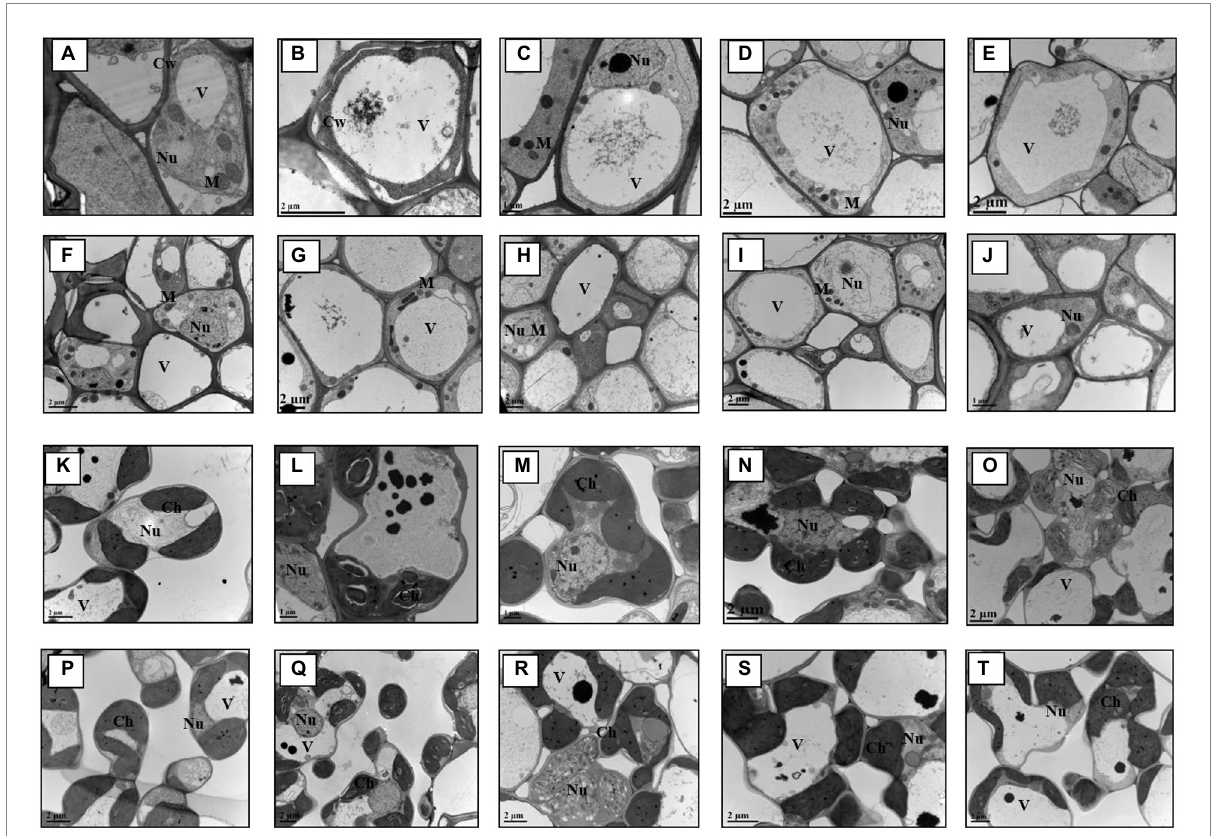
FIGURE 3 Transmission electron micrographs of root and leaf cells. Key: (A–J) = Root; GD-6: A = Control; B = As; C= Serendipita indica + As; D = S. indica + As + Phosphorus; E = As + Phosphorus; ZZY-1: F=Control; G = As; H= S. indica + As; I = D= S. indica + As + Phosphorus; J = As + Phosphorus. (K–T) = Leaves; GD-6: K=Control; L = As; M = S. indica + As; N= S. indica + As + Phosphorus; O = As + Phosphorus. ZZY-1: P=Control; Q = As; R = S. indica + As; S= S. indica + As + Phosphorus; T = As +